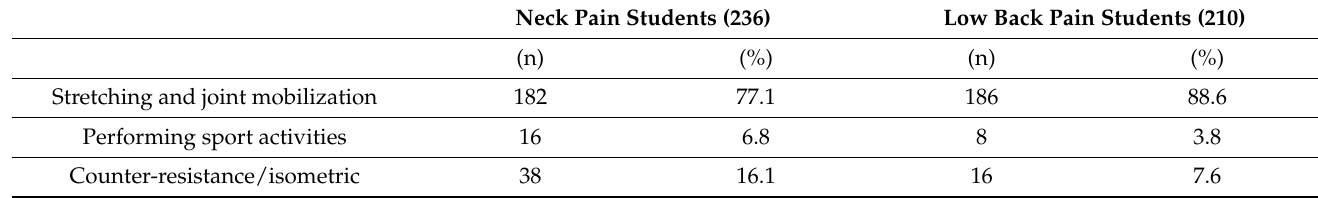
Table 5. Exercise classification of those choosing exercises as pain relief